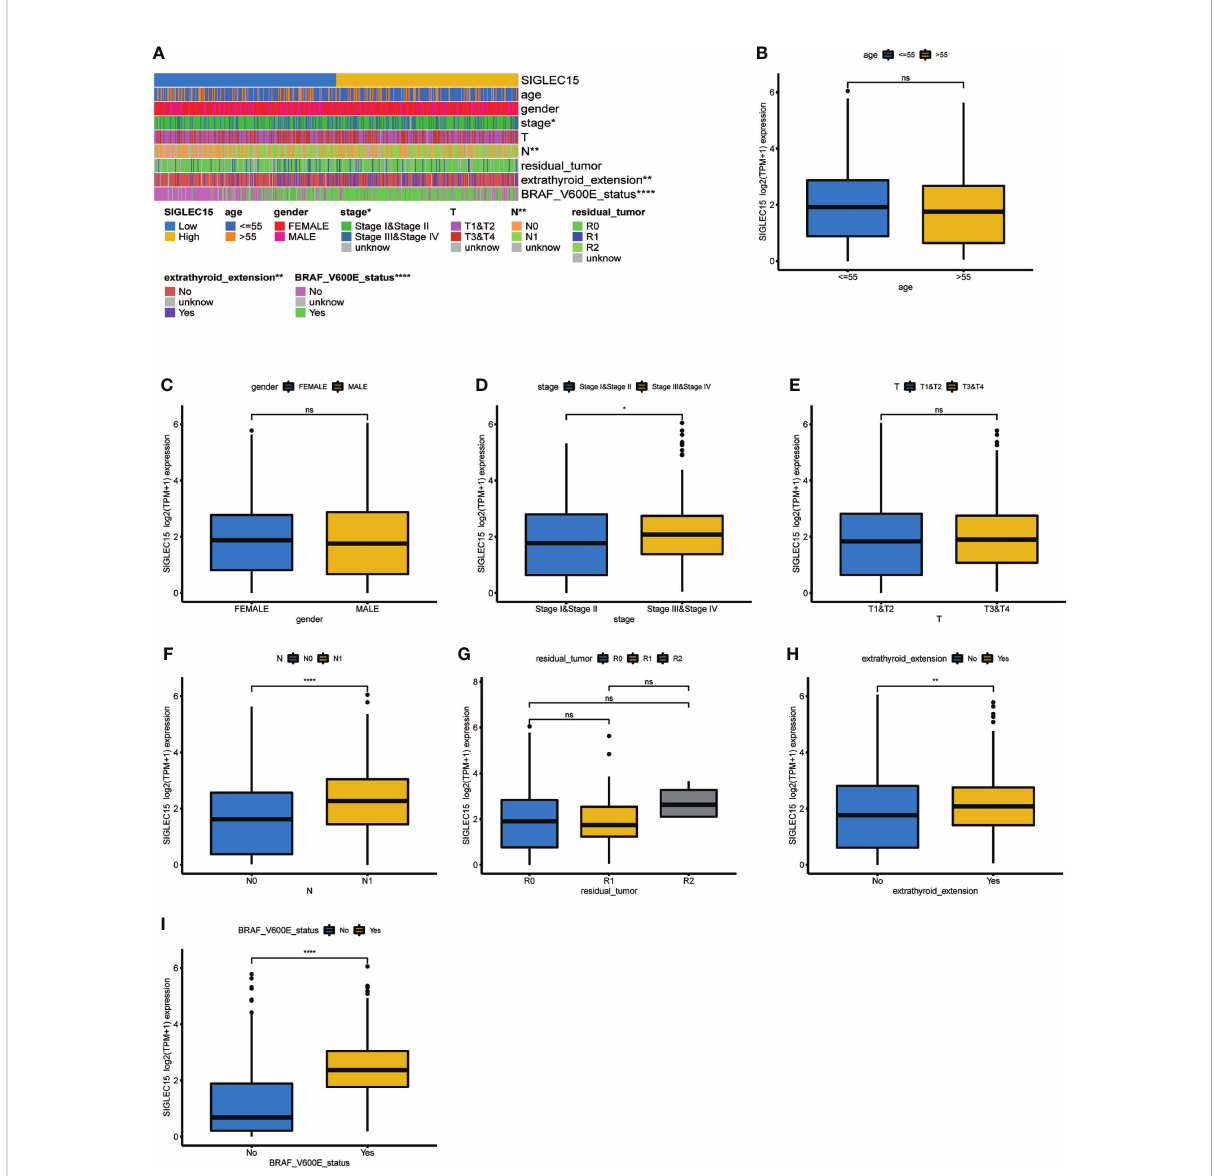
FIGURE 7 Clinical signi fi cance of SIGLEC15 . (A) Heatmap of clinical feature correlation with SIGLEC15 . (B – I) High and low SIGLEC15 mRNA expression group difference in (B) Age, (C) Gender, (D) Stage, (E) T stage, (F) N stage, (G) Tumor residual size, (H) Extrathyroid extension, and (I) BRAF V600E status. ns, *, **, ***, and **** stand for p-value >0.05, p-value <=0.05, p-value <=0.01, pvalue <=0.001 and pvalue <=0.0001,